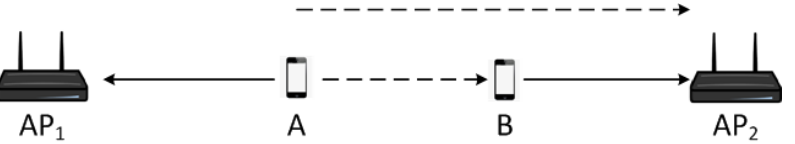
Figure 3. An exposed terminal scenario. Node A is exposed to node B, so node B unnecessarily defers its packet even both transmissions can take place in